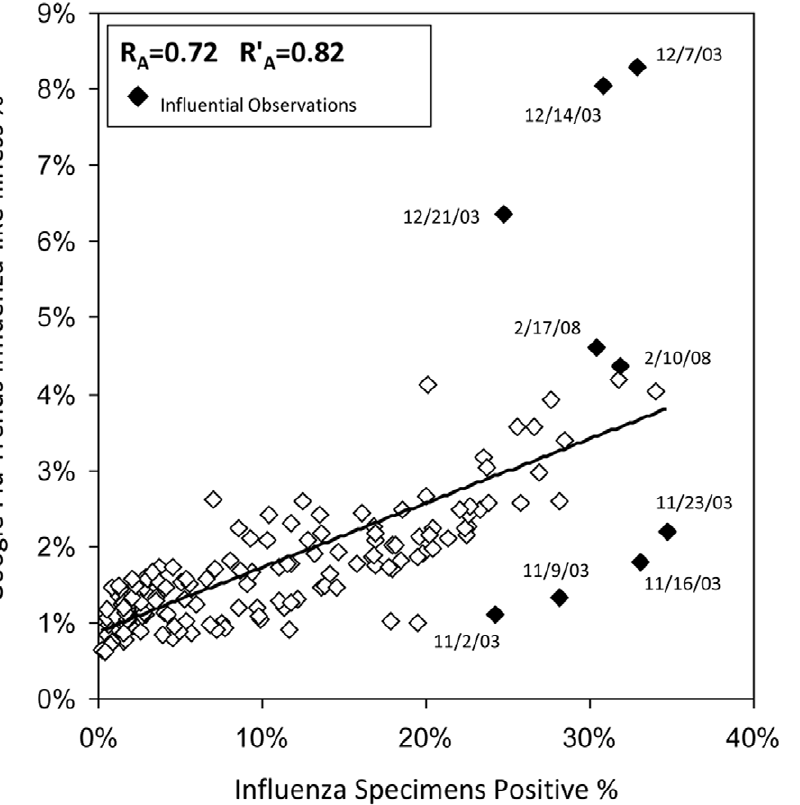
Figure 2. Scatter Plot Google Flu Trends and CDC Influenza Laboratory Surveillance; September 28, 2003 through May 17, 2008. 1. Data Sources: a. US Influenza Virologic Surveillance System (http://www.cdc.gov/flu/weekly/fluactivity.htm); and b. Google Flu Trends (http:// www.google.org/about/flutrends/us-historic.txt). 2. There are 166 total observations in each panel. Influential observations were defined by DFBETA statistic greater than the absolute value of 2 divided by the square root of the total number of observations in a simple linear regression model [17]. 3. R A represents Pearson’s correlation coefficients calculated from comparisons of Google Flu Trends with US Influenza Virologic Surveillance. 4. R’ A represents the calculated Pearson’s correlation coefficients after exclusion of all influential observations. 5. Because CDC surveillance is intensified from calendar week 40 through calendar week 20 of the subsequent year, we restricted our correlation analyses to this time period.